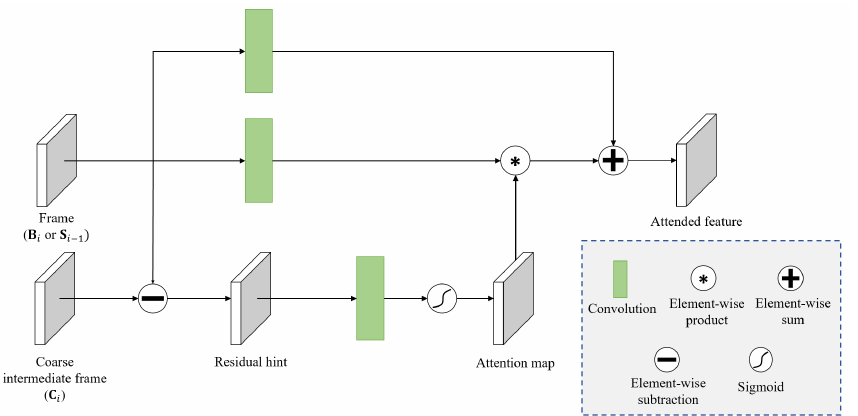
Figure 3. Structure of the residual hint attention (RHA)